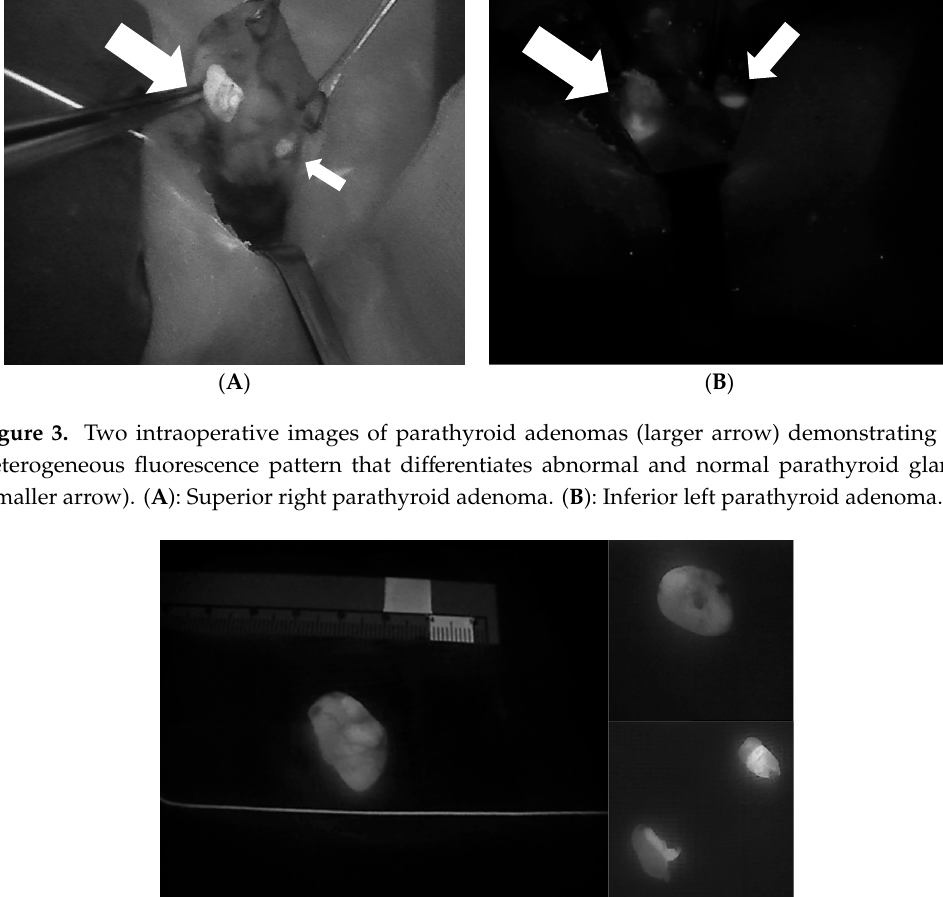
Figure 4. Heterogeneous autofluorescence patterns in parathyroid adenomas .